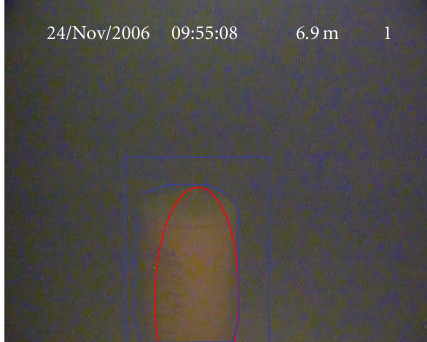
Figure 13: Segmentation of a mine at sea. C good = 0 . 57 and C false = 7 . 10 − 3